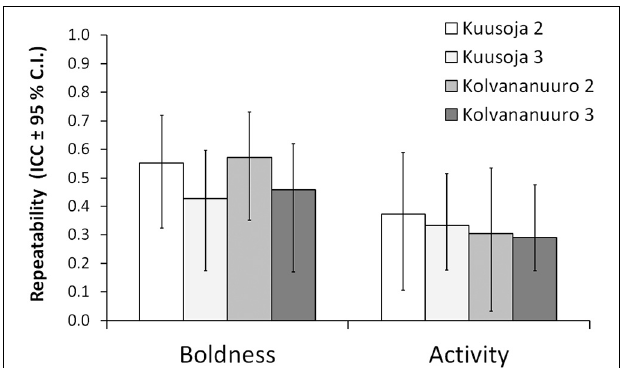
FIGURE 2 | Repeatabilities for boldness and activity in the two study populations (Kuusoja River and Kolvananuuro Brook) over two and all the three trials.